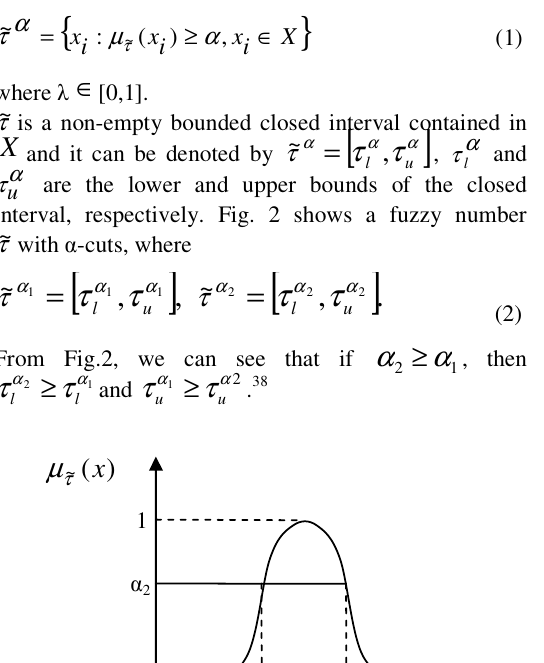
Table 1: Website quality evaluation models in literature Attributes of website quality